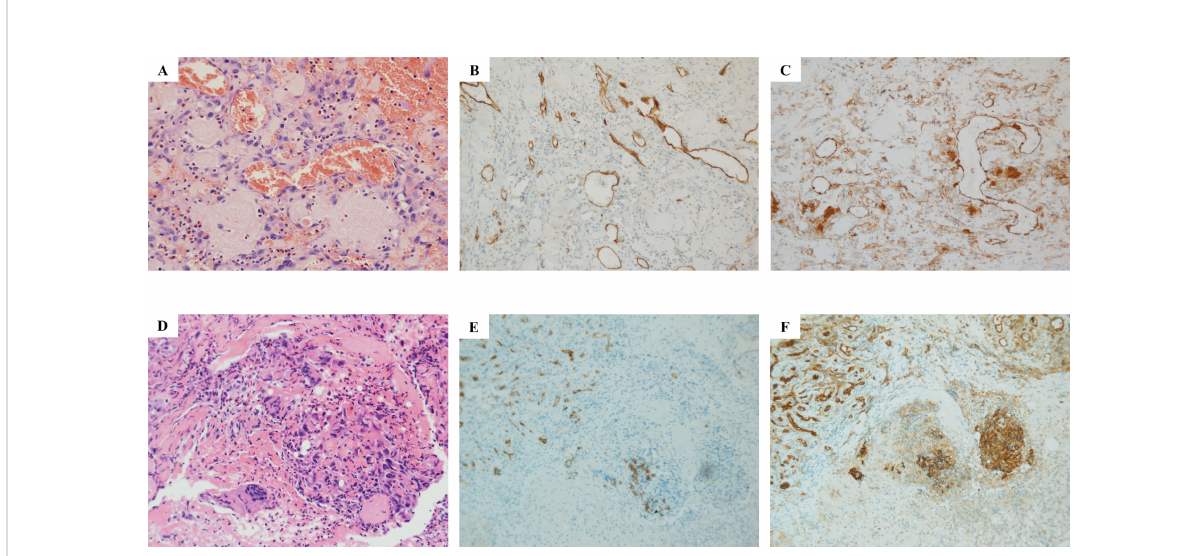
FIGURE 1 Histopathological examination results of parotid gland and scalp metastasis. Hematoxylin – eosin (HE) staining showed that salivary gland tissue was found in the sample tissue of the left parotid gland mass, and fi brous tissue hyperplasia was observed in some areas (A – C) Atypical cells were seen near the granulation tissue, which was indicated by immunophenotype as endovascular cells, and in fi ltration of lymphocytes and plasma cells was also observed, accompanied by bleeding (A) . Immunohistochemical results showed CD34 negative (B) and CD31 positive (C) . As for the HE result of scalp metastasis (D, E) , squamous mucosa, epithelial erosion, a small amount of increased cytoplasmic ratio, irregular karyotype, and trace lesion tissue (D) were shown. Immunohistochemical results showed CD34 negative (E) and CD31 positive (F)